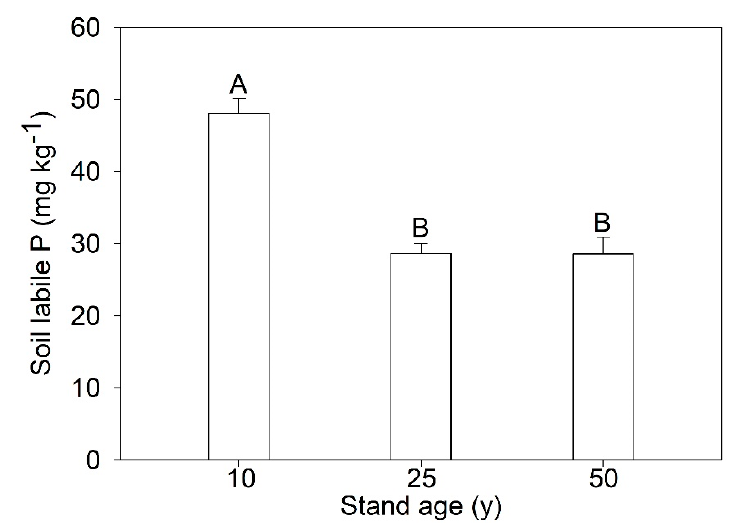
Figure 3. Variations in the concentration of soil labile P (the sum of Resin-P, NaHCO 3 -Pi, and NaHCO 3 -Po) with stand age on larch plantation. Thick bars represent the means and thin bars represent standard errors for n = 3. Different letters indicate group with significant differences for p < 0.05.